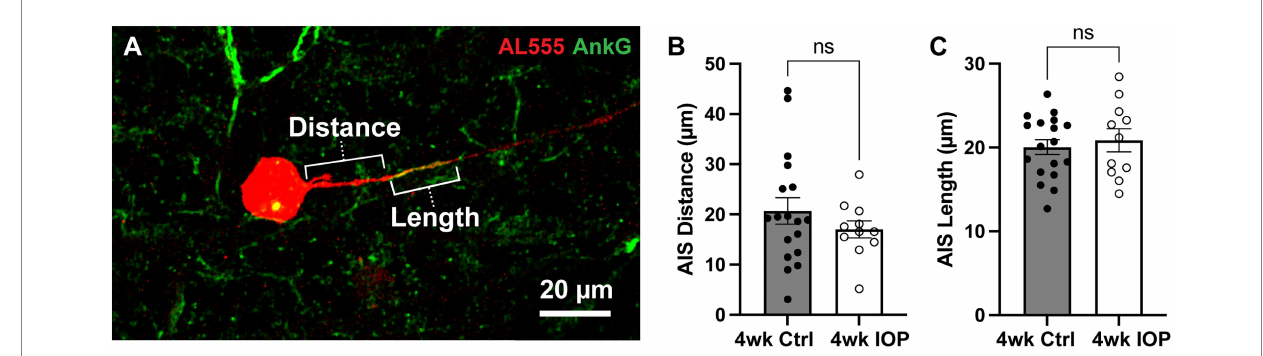
FIGURE 6 Axon initial segment dimensions are unchanged by IOP elevation. (A) Representative image of Alexa 555 (AL555, red) dye-filled RGC labeled for the axon initial segment (AIS) scaffolding protein ankyrin-G (AnkG, green). Annotations demonstrate the dimensions of AIS distance from soma and length which are quantified. (B,C) The AIS distance from the soma (B) and length (C) for all RGCs with AnkG-labeled axons. 4wk IOP does not significantly alter either of these dimensions (Distance: p = 0.3194, unpaired t -test; Length: p = 0.6007, unpaired t -test). Error bars: ± standard error of the